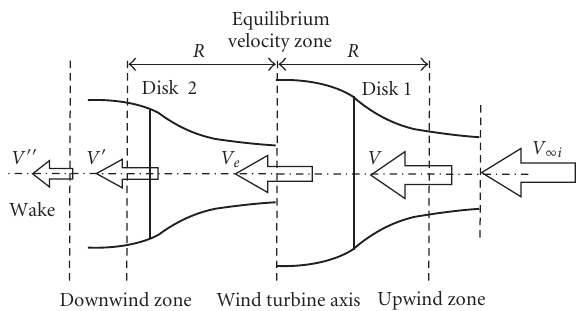
Figure 1: The two actuator disks